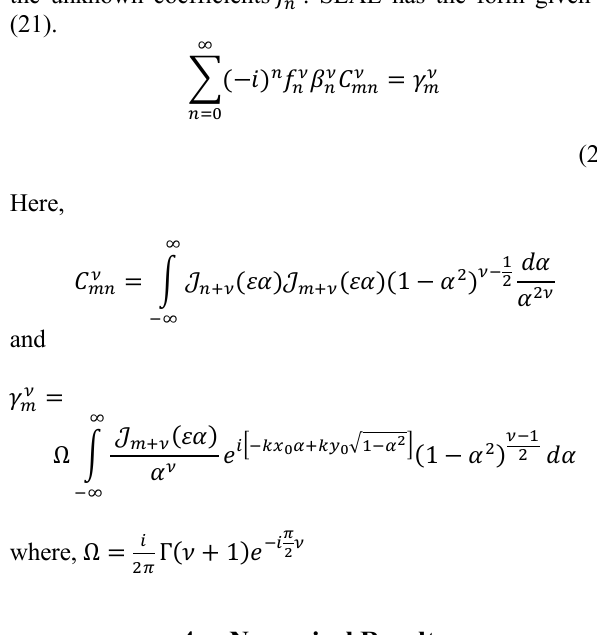
Figure 4: The Amplitude of the Scattered Electric Field 𝐸Q⃗ Ab for 𝑎 = 1 , 𝜖 = 𝜋 , 𝑥